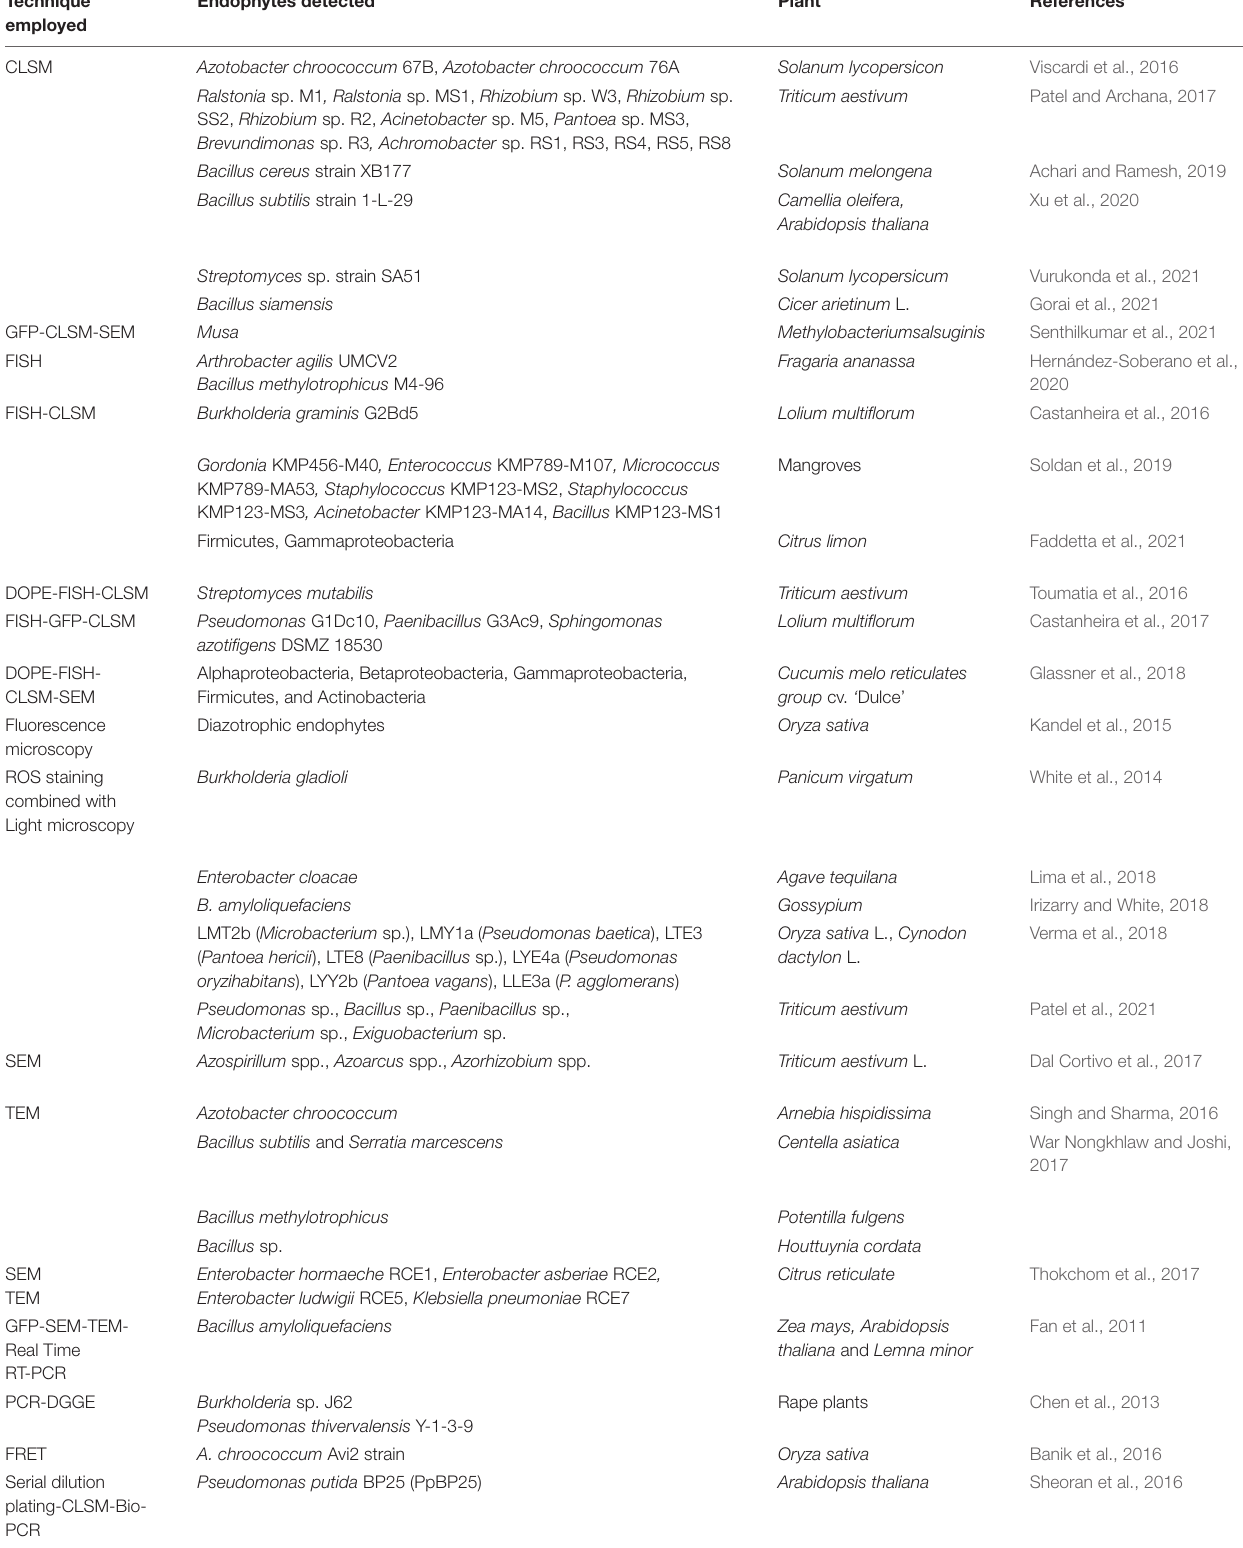
TABLE 2 | Detection of